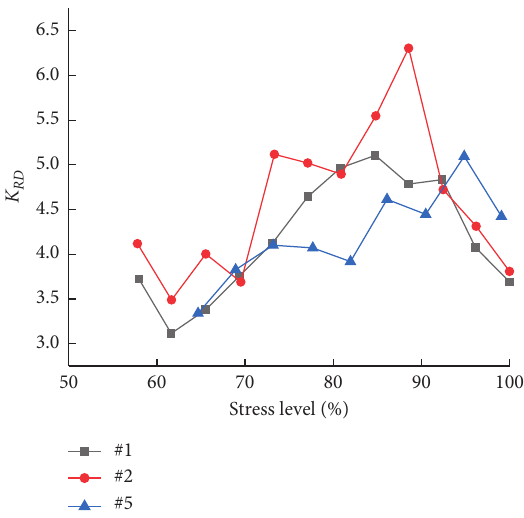
Figure 10: Relationship between the rebound deformation index and stress level. Table 1: Measurement results of the coal seam rockburst tendency.